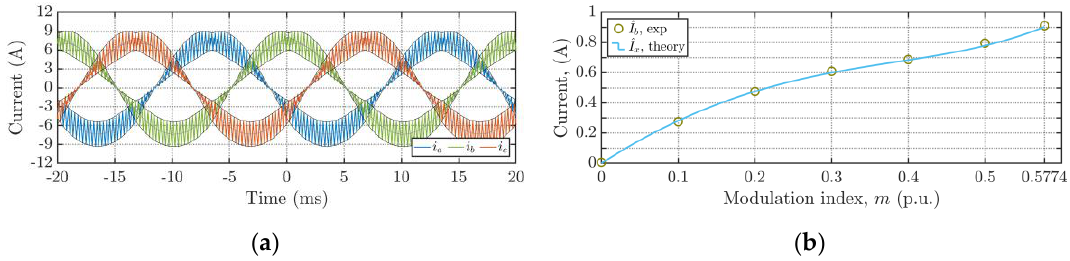
Figure 38. ( a ) Phase currents with primary (black) and secondary (gray) envelopes in case of